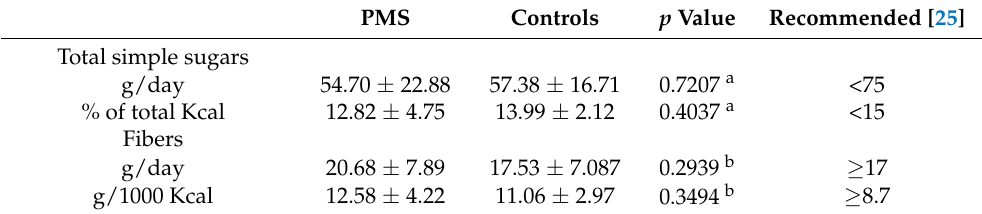
Table 3. Estimated daily carbohydrate intakes in the participating